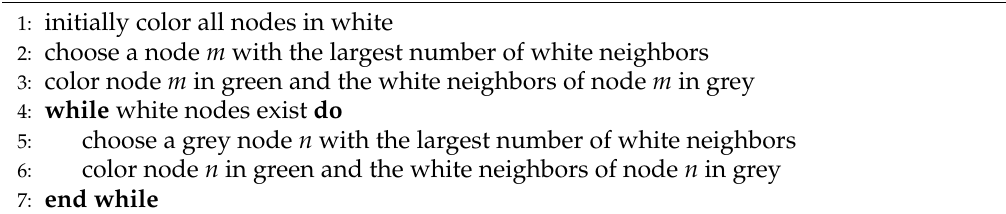
Algorithm 1 Greedy tree growing algorithm.